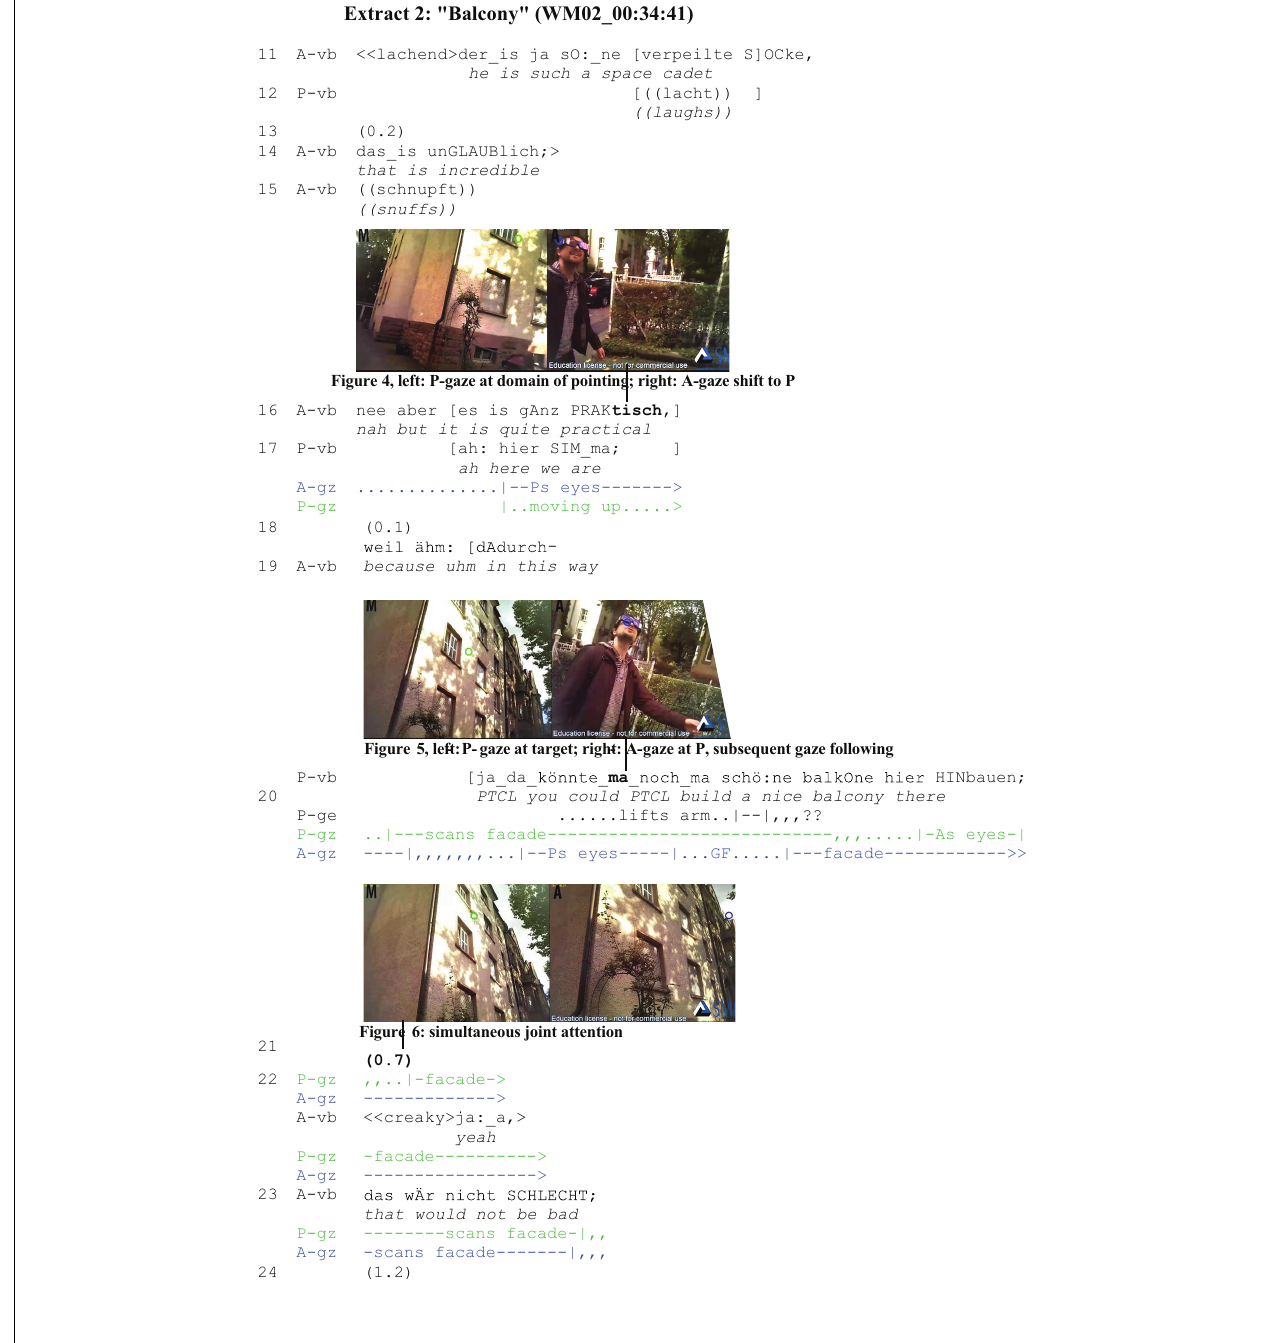
Figure 4, left: P-gaze at domain of pointing; right:A-gaze shift to P